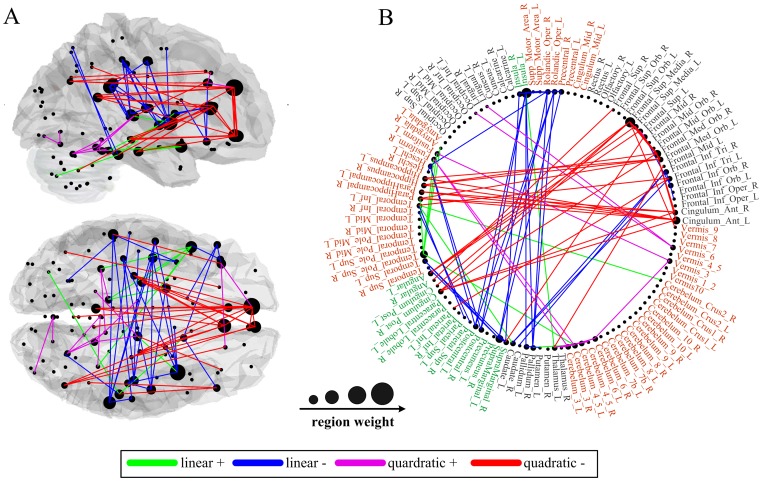
Age-related changes in interregional functional connectivity displayed on (A) a surface rendering of the brain and (B) a schematic diagram.Connections with positive linear, negative linear, positive quadratic and negative quadratic developmental trajectories are shown in green, blue, magenta, and red, respectively. Also displayed are the brain regions scaled by their weights (sum of the T statistics for all the connections passing through that brain region).